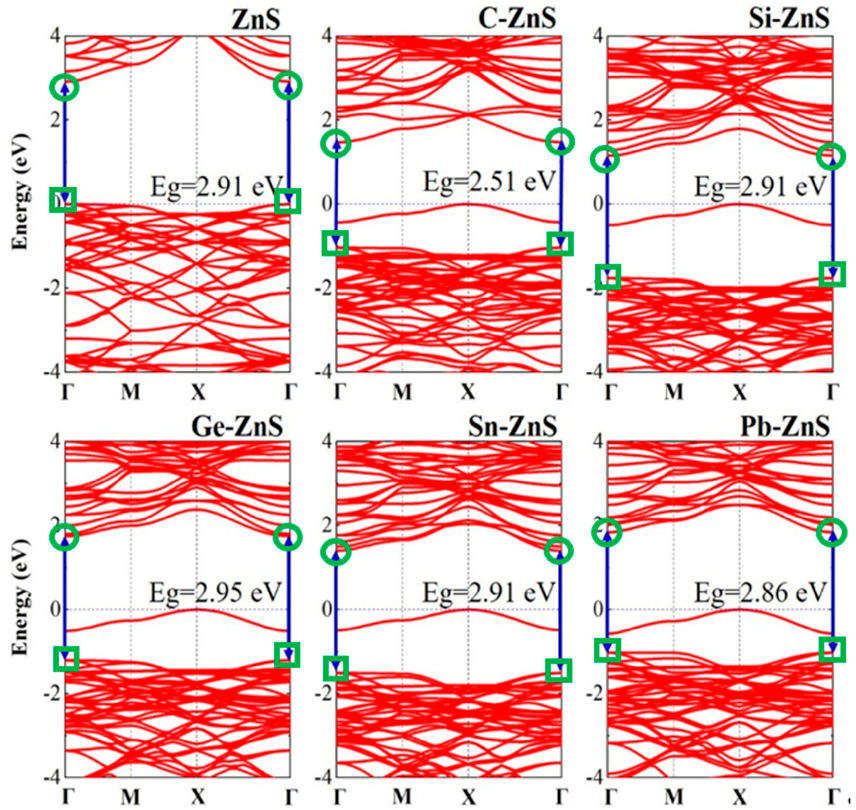
Figure 4. Band structures of the ZnS monolayer and the corresponding doped models. The circle and rectangle symbols represent the CBM and VBM, respectively.